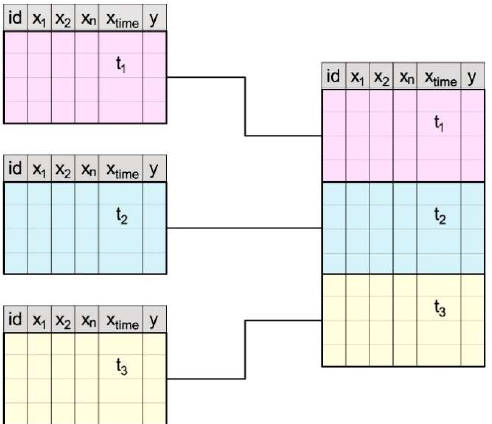
Figure 6. Process of data appending to create the pooled cross-sectional dataset. Note: id = identifier; x 1 , x 2 , ..., x n = each of the independent features; x time = time feature; t 1 , t 2 , t 3 = each of the time periods (quarters); y = dependent feature ( ln_price ).